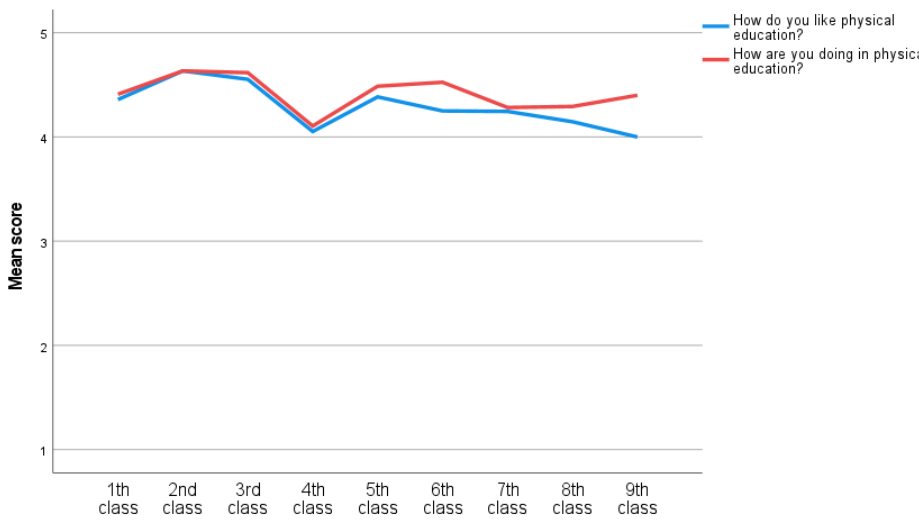
Figure 4. How do you like and how are you doing in physical